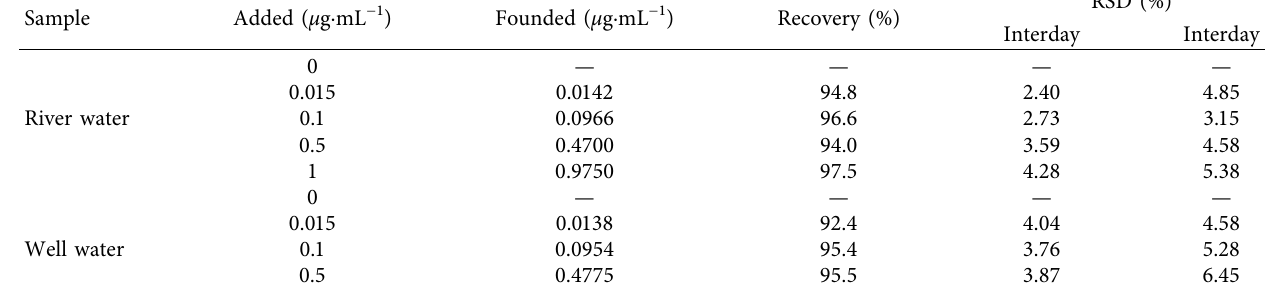
Table 2: Analysis of phenobarbital in spiked real water samples by SPME-MIP with HPLC-UV Sample